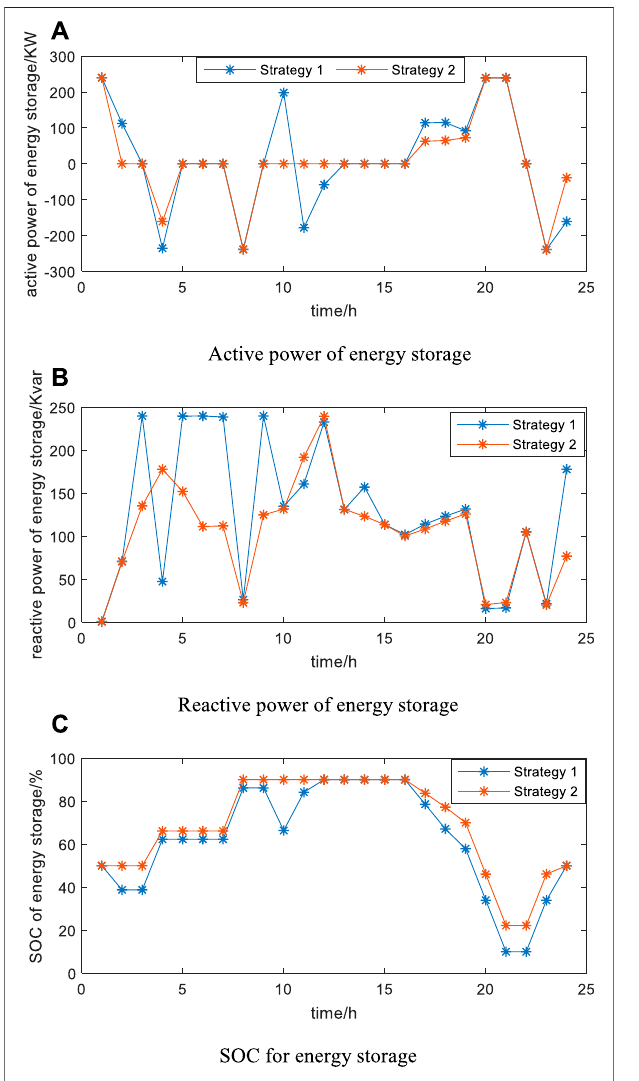
FIGURE 5 | Energy storage powers of strategy 1 and strategy 2. (A) Active power of energy storage. (B) Reactive power of energy storage. (C) SOC for energy storage.